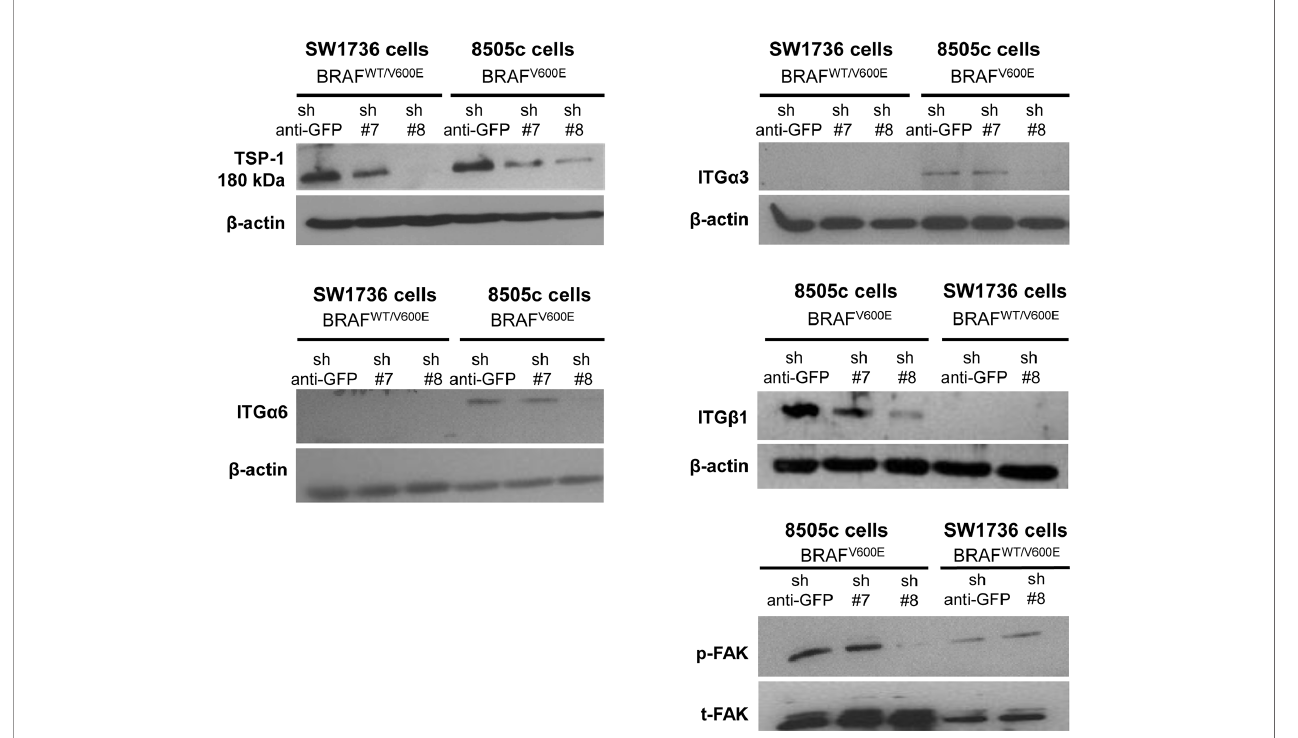
FIGURE 1 | TSP-1, ITG a 6, ITG a 3, ITG b 1, and pFAK protein levels by western blot in human anaplastic thyroid cancer (ATC) cell lines with sh-GFP (green fl uorescent protein, control) or knock-down of TSP-1 (#7 and #8) harboring heterozygous BRAF WT/V600E (SW1736 cells) or homozygous BRAF V600E (8505c